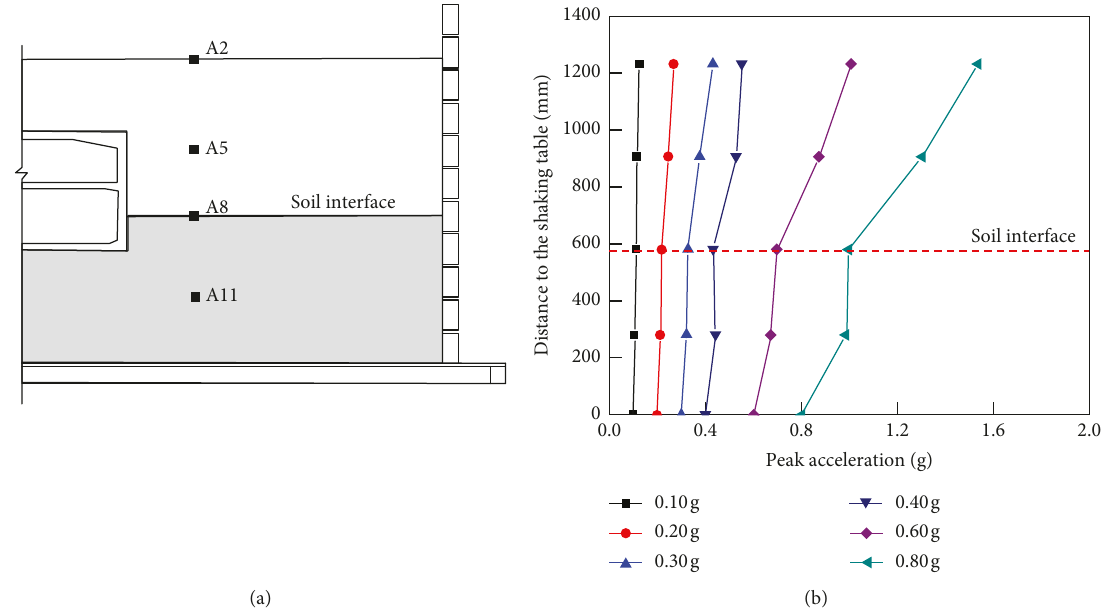
Figure 13: Peak accelerations of the model soil under the Kobe ground motion.